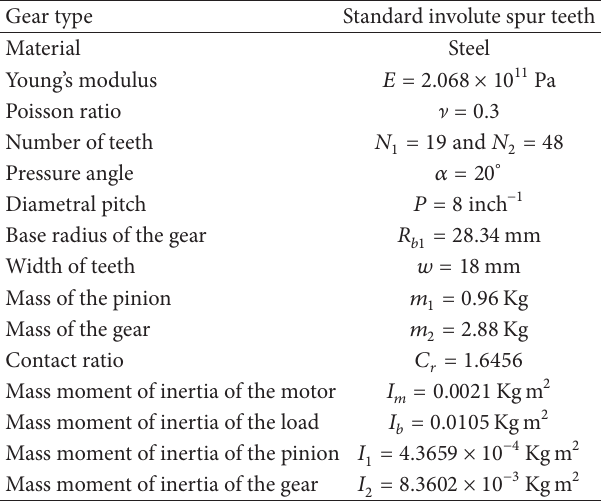
Table 3: Main parameters of the gear